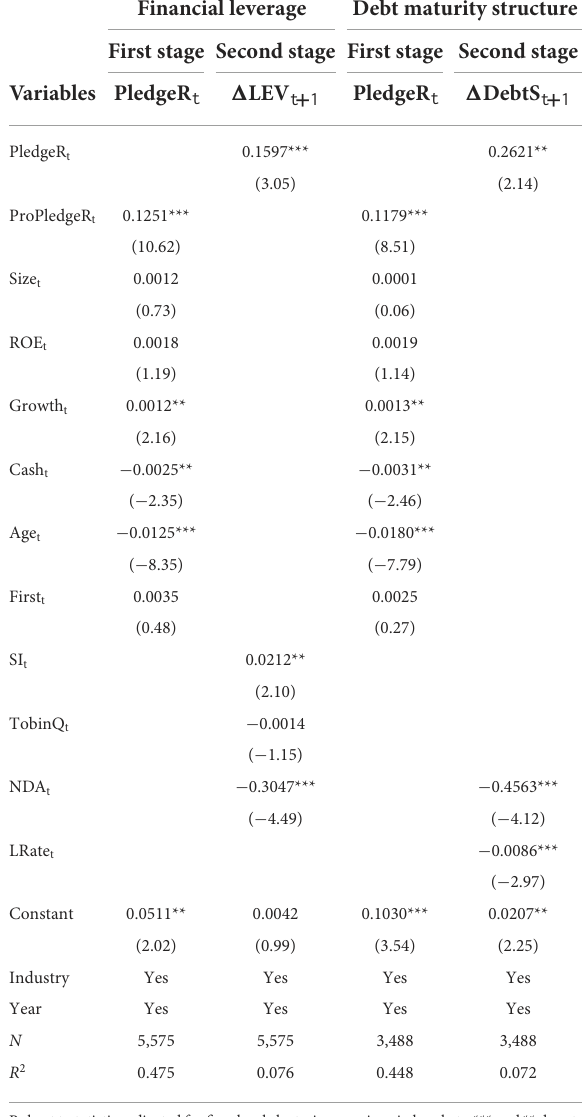
TABLE 7 The regression results of